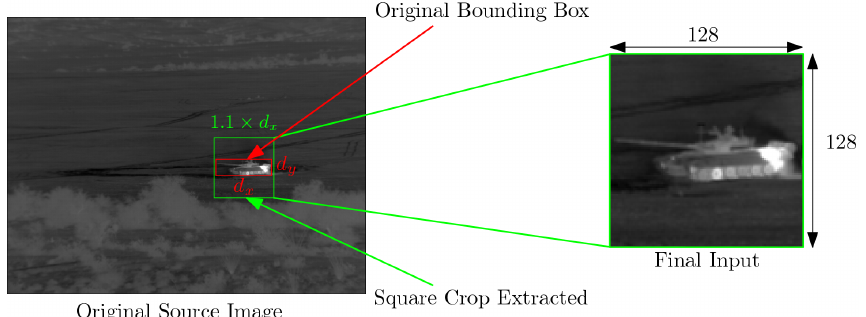
Figure 3. An extracted patch image (in green) from the original infrared image using the original bounding box information (in